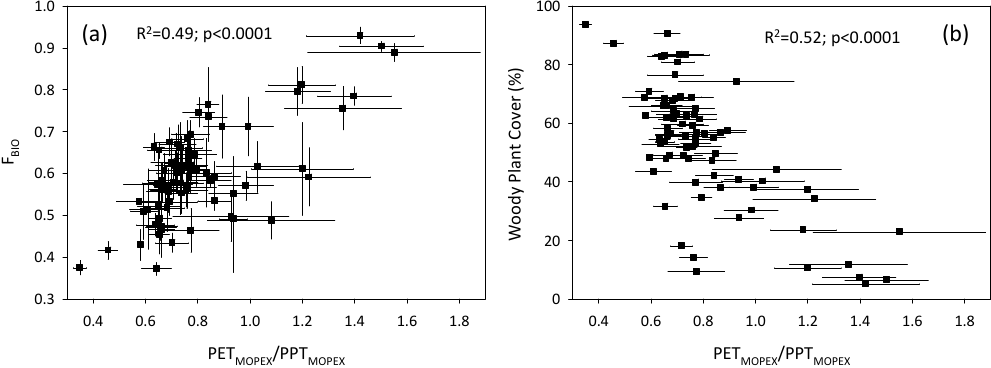
Fig. 3. The relationship between (a) the fraction of effective energy and mass transfer (EEMT) derived from biological energy input ( F BIO ) and (b) the catchment percent woody plant cover relative to the ratio of potential evapotranspiration to precipitation (PET/PPT). Error bars in (a) are standard errors of the annual means over the period of record; error bars in (b) are standard errors of the annual means over the period of record for PET/PPT. Woody plant cover was taken from 2001 NLCD database, which does not represent annual variation in percent woody plant cover. As such, error bars were not included for percent woody plant cover.